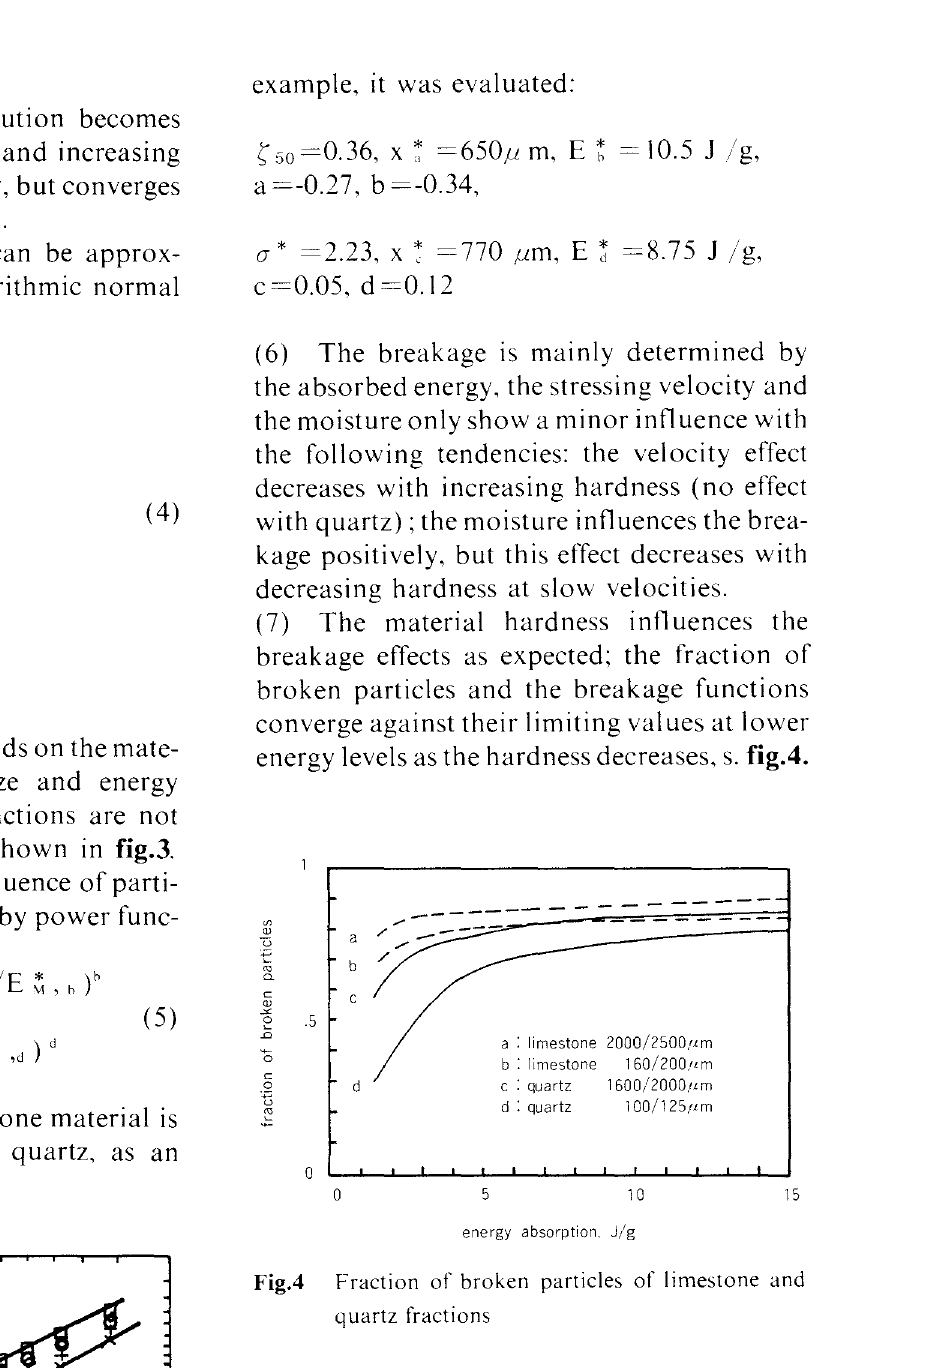
Fraction of broken particles of limestone and quartz